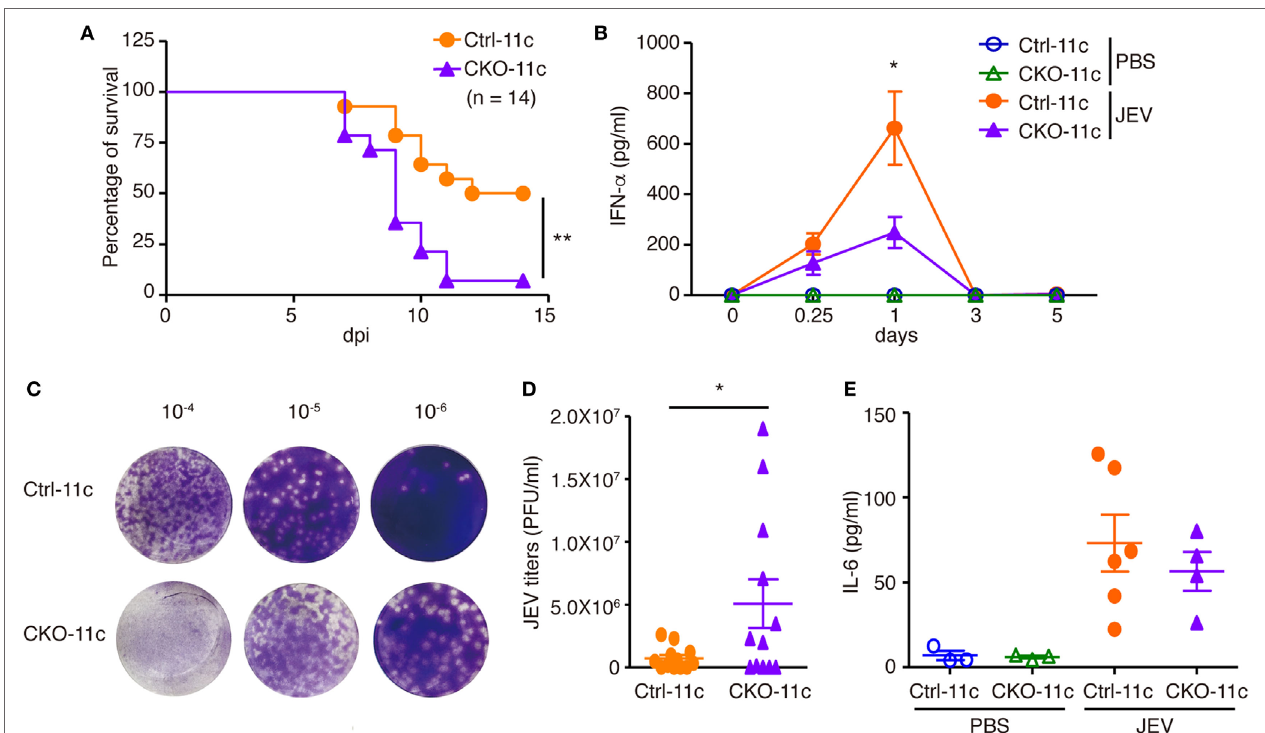
FigUre 6 | Impaired antiviral responses in mice lacking Blimp-1 in DCs. (a) Survival rates of Ctrl - 11c or CKO - 11c mice infected with Japanese encephalitis virus (JEV) (5 × 10 4 pfu) by intraperitoneal (i.p.) injection followed by intracerebral (i.c.) needle injury. dpi: days post-infection. (B) ELISA measurement of IFN- α at different days post-PBS injection or post-JEV infection in Ctrl-11c and CKO-11c mice serum. (c,D) Plaque assay showing JEV titers in Ctrl - 11c and CKO - 11c mouse brains at 6 days post-infection (c) . Quantitation of results from panel (c) is (D) . (e) ELISA showing serum IL-6 levels 24 h after JEV infection or PBS injection in Ctrl-11c and CKO-11c mice. Data in (a) was analyzed by log-rank (Mantel-Cox) test ( n = 14). Data in (B,D,e) represent the mean ± SEM and were analyzed by two-tailed unpaired Student’s t -test [ n = 10 − 13 in 0.25 and 1 dpi and 3 − 5 in 0, 3, and 5 dpi and PBS injected group in (B) , 12 in (D) , and 3 − 6 in (e) ]. * p < 0.05; ** p <